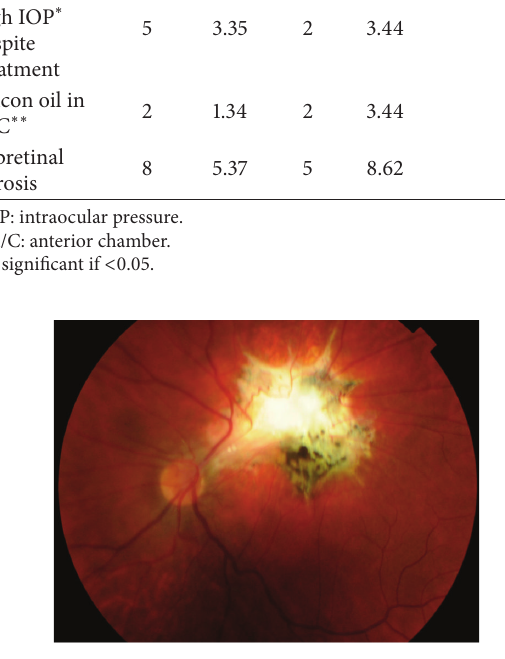
Figure 1: Color photo of left eye showing parafoveal exit with macular dragging.